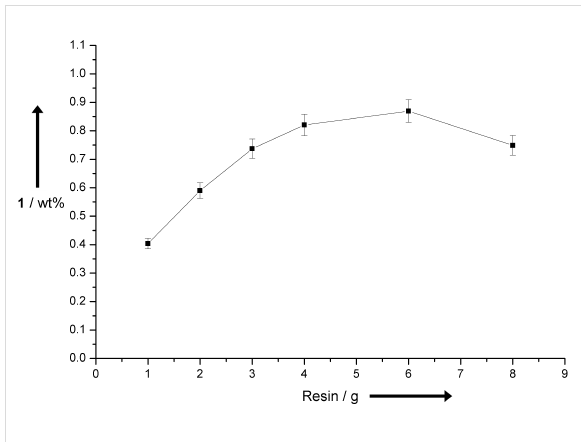
Figure 8: Recovery of vanillin ( 1 ) by adsorption from lignin containing reaction solutions after electrochemical treatment at Ni foam elec- trodes. Different amounts of resin were applied in a batch process. Desorption was performed treating the loaded resins with an acidic solution (EtOAc/AcOH, 8:2) in a batch process.